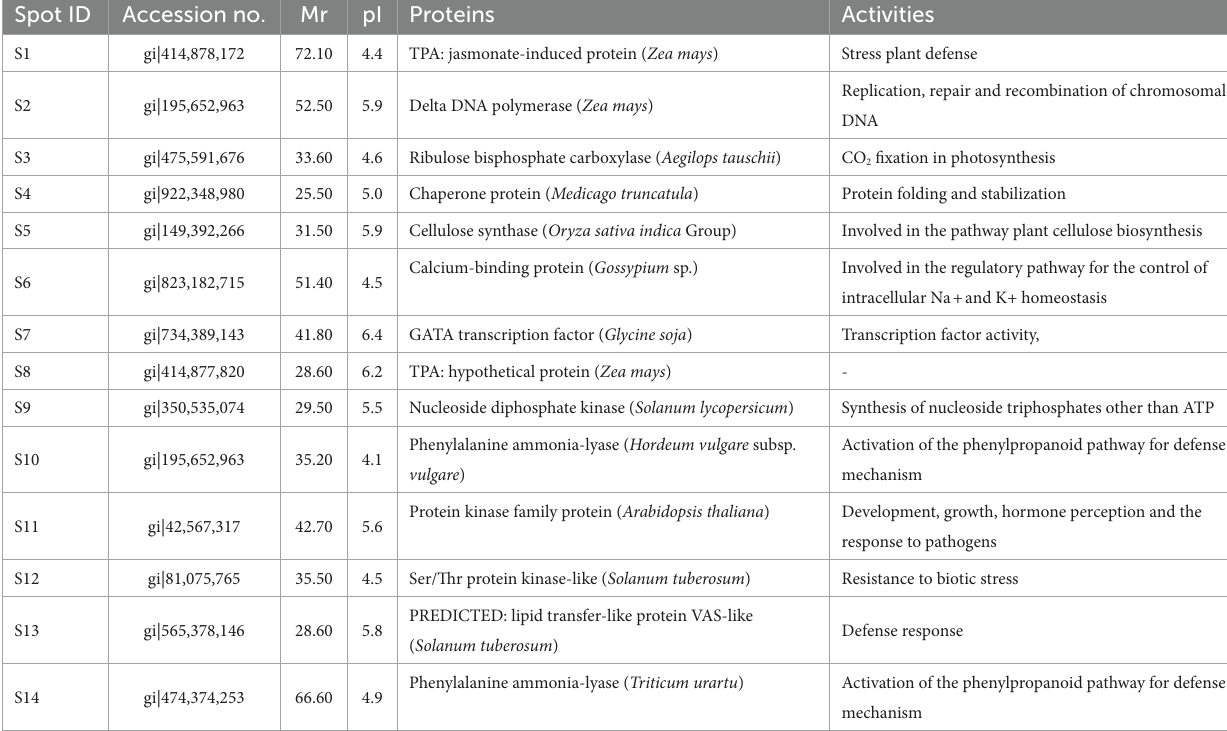
TABLE 4 Differentially expressed proteins and their